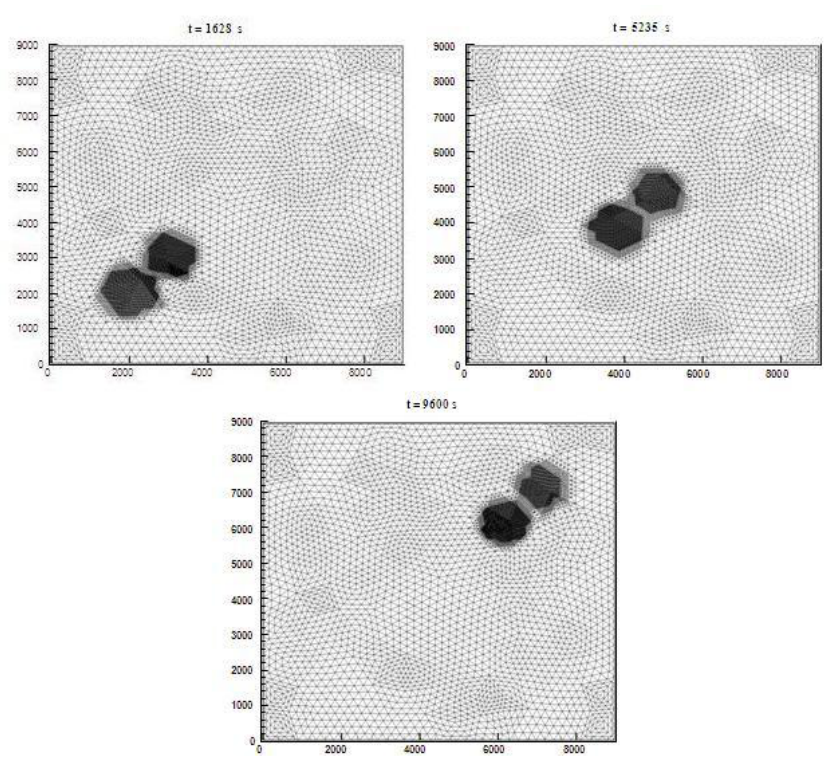
Fig. 3 contours of pollutant concentration at 3 simulation times: t = 1628 s, 5235 s and 9600 s